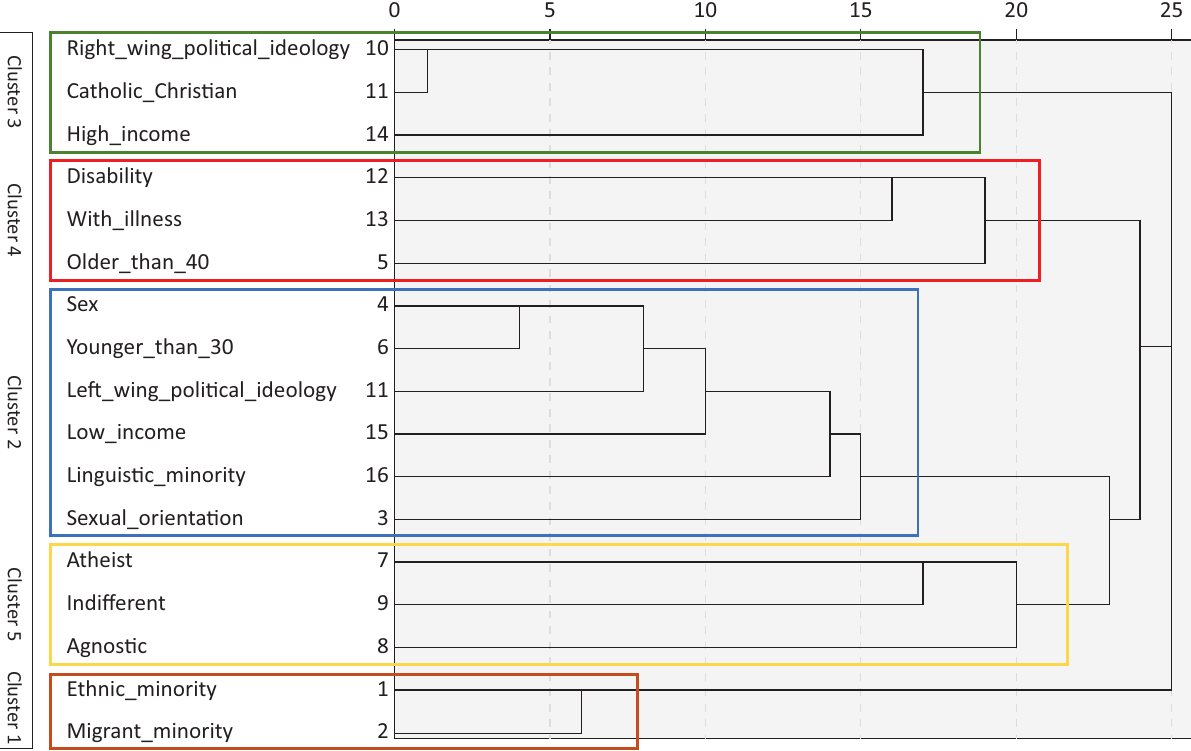
Figure 3. Dendrogram: Feeling of